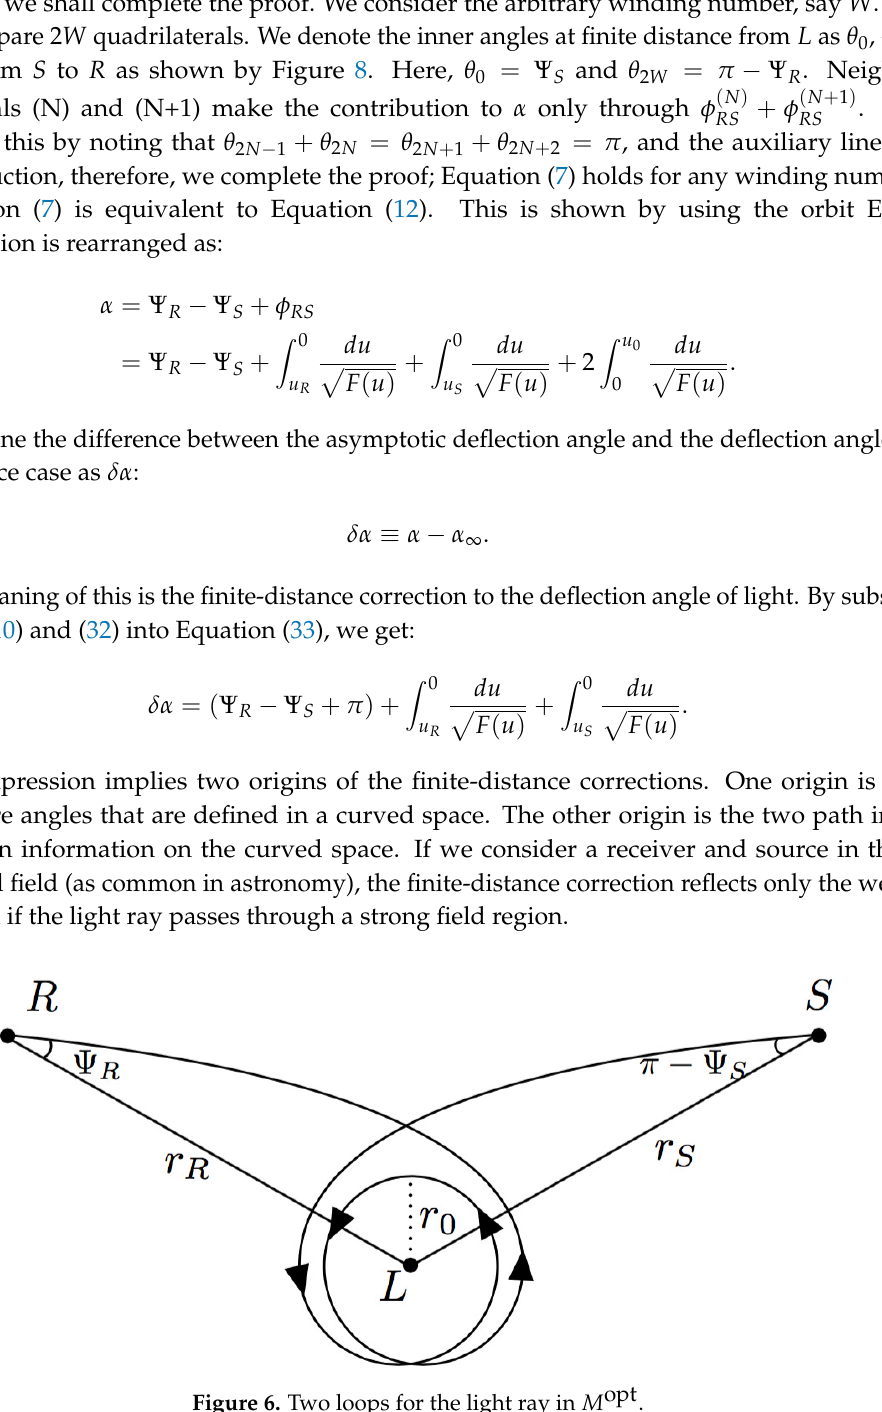
Figure 6. Two loops for the light ray in M opt